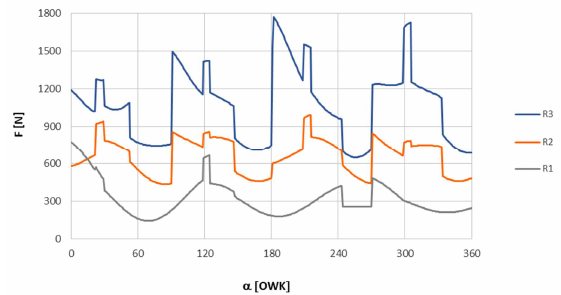
Fig. 15. The reaction values in camshaft bearings as a function of the rotational angle for its average rotational speed of 2000 rpm and belt tension of 200 N